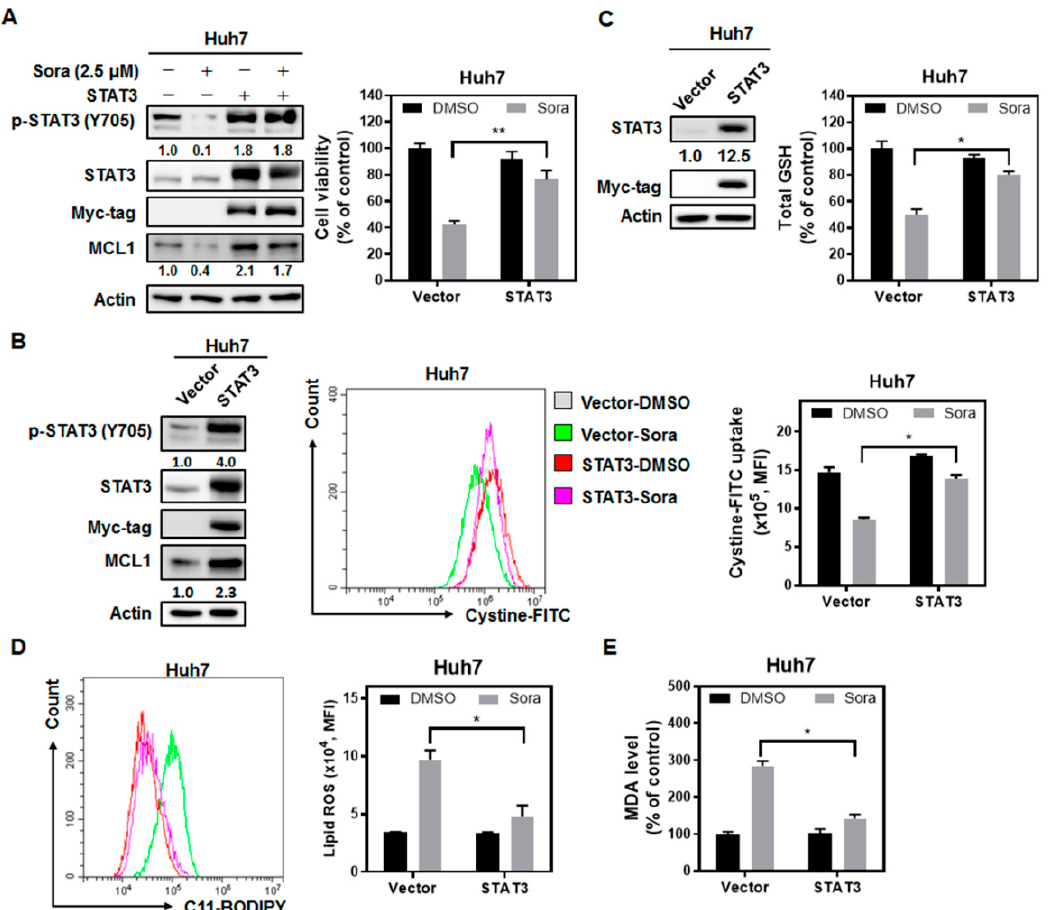
Figure 4. STAT3 plays a core role in mediating sorafenib-triggered ferroptosis in HCC cells: ( A ) Ectopic expression of STAT3 not only alleviated the inhibitory effects of sorafenib on MCL1 expression ( left panel ) and cell viability ( right panel ), but also ( B ) recovered cystine uptake, ( C ) restored GSH content, ( D ) reduced lipid ROS, and ( E ) lowered the levels of MDA. Columns: mean; bars: SD (n ≥ 3). Statistical significance was evaluated using the Mann–Whitney U test (*, p < 0.05; **, p < 0.01).